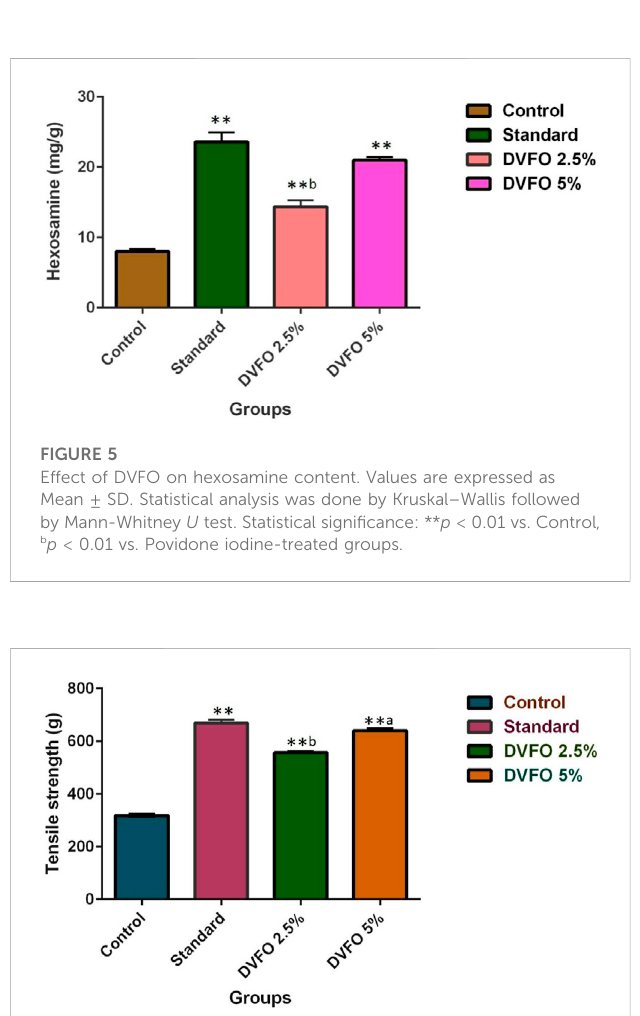
FIGURE 6 EffectofDVFOonTensilestrength.ValuesareexpressedasMean± SD. Statistical analysis was done by Kruskal – Wallis followed by Mann- Whitney U test. Statistical signi fi cance: ** p < 0.01 vs. Control, a p < 0.05, b p < 0.01 vs. Povidone iodine-treated